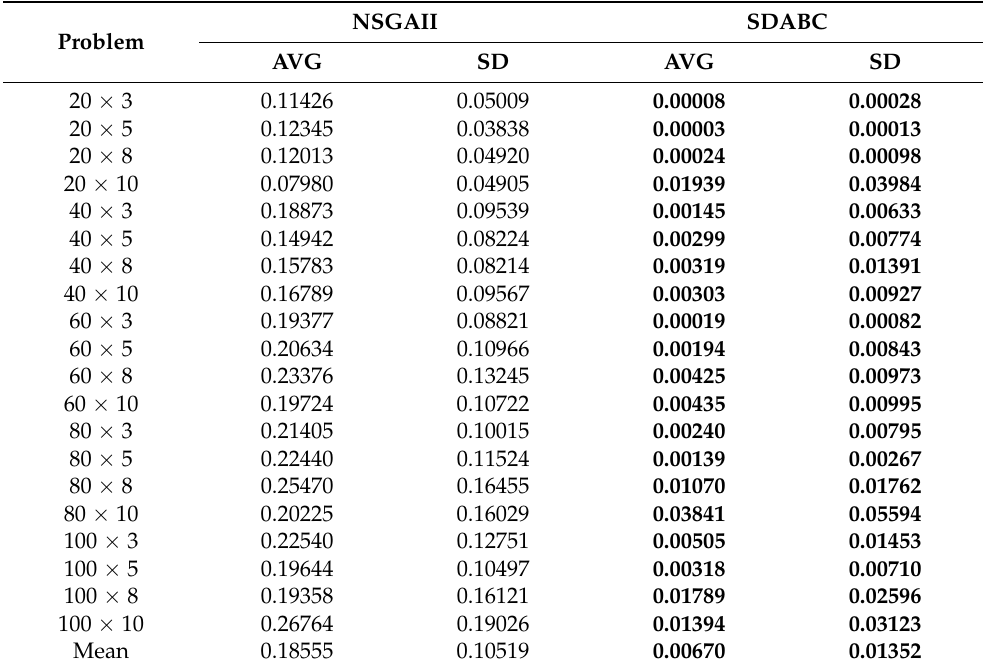
Table 13. IGD -metric for SDABC and